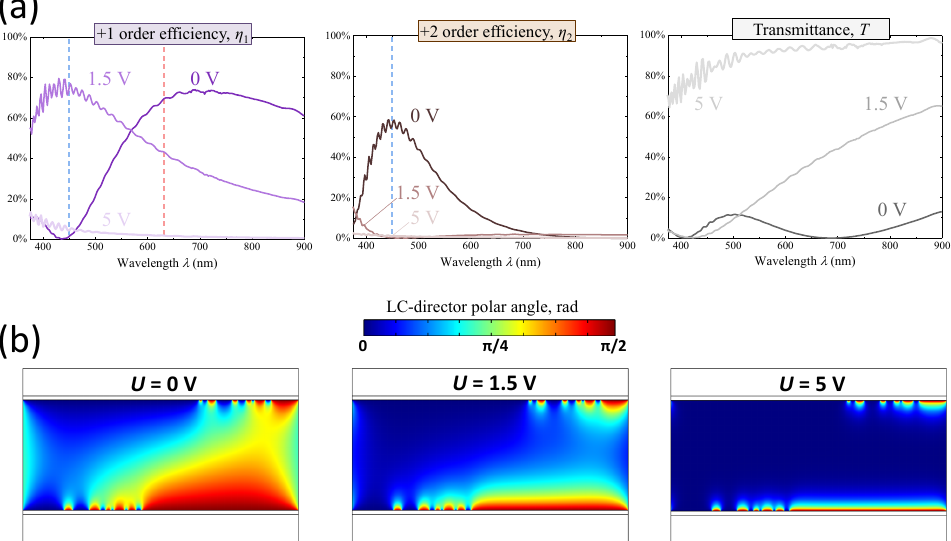
Figure 2. Optimized multiplexed 10 µ m periodic double-sided LC-metasurface. Numerically ob- tained spectra of diffraction efficiencies of +1 and +2 orders, and direct transmittance at three different voltages with the target wavelengths of 450 nm and 630 nm indicated by vertical dashed lines ( a ). Colormaps of the simulated spatial distribution of the LC director polar angle within one metasurface period at three voltages ( b